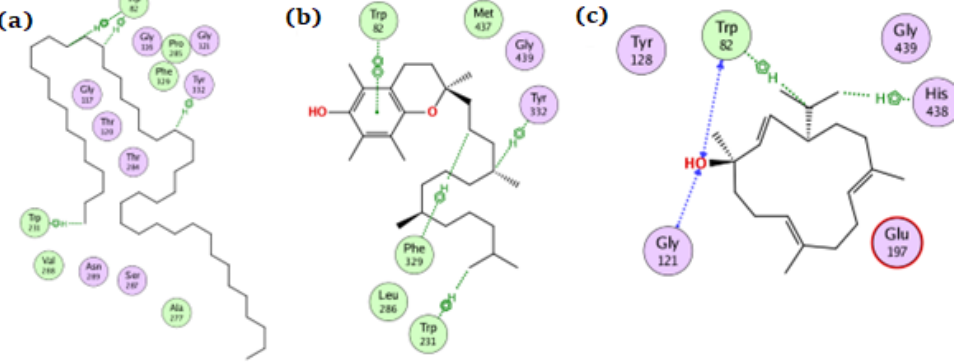
Figure 5. The docking of ( a ) tetratetracontane, ( b ) α -tocopherol, and ( c ) thunbergol on the active site of BChE enzyme (PDB code: 6esj).